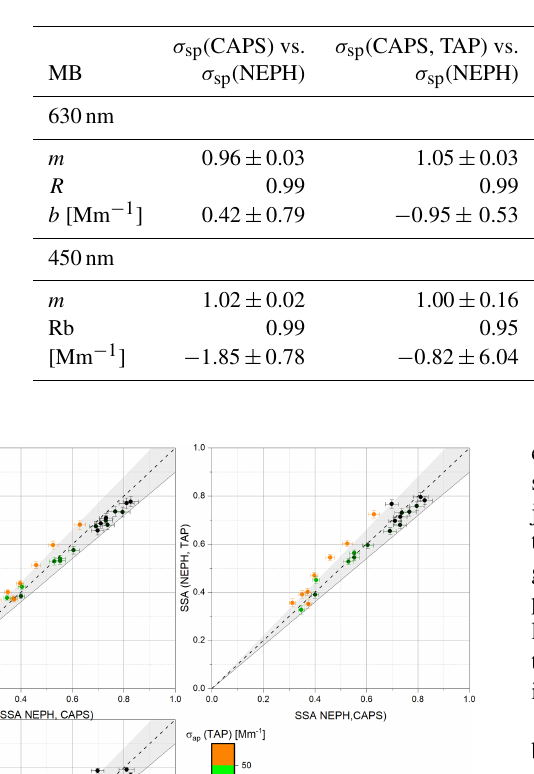
Table 9. Linear regression results of scattering ( σ sp ), extinction ( σ ep ) and absorption ( σ ap ) coefficients for external mixtures of MB and AS particles, given as slopes ( m ), Pearson R and y axis intercepts ( b ).